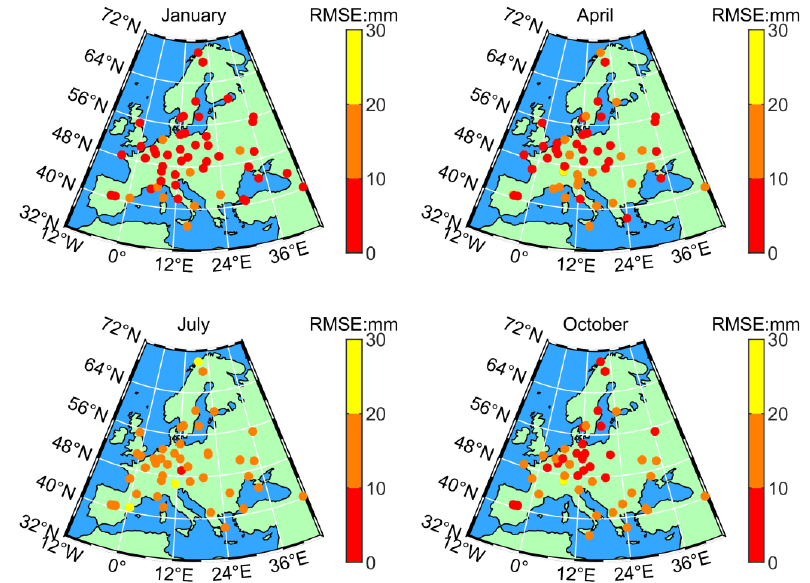
Figure 7. RMSE values of ERA5P-ZTD at all available IGS stations in January, April, July, and October of 2018. These RMSE values of ERA5P-ZTD are always less than 20 mm.